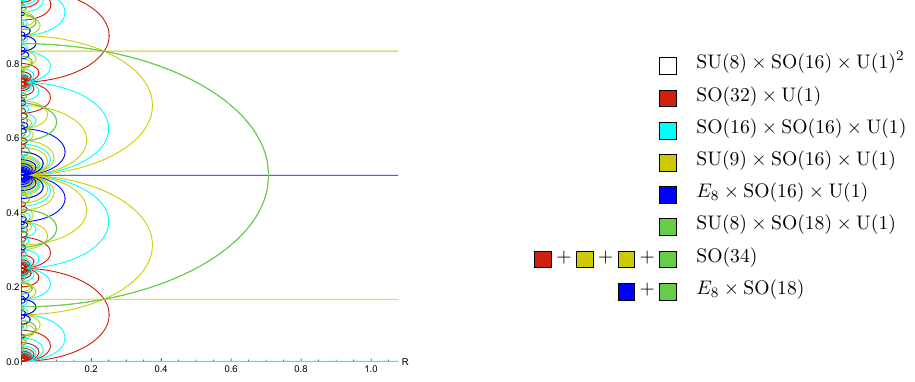
Figure 25. (cid:0) 8 (cid:2) (cid:0) 8 heterotic with Wilson line A I = (( A ) 7 ; 1 (cid:0) A; 1 ; 0 7 ).